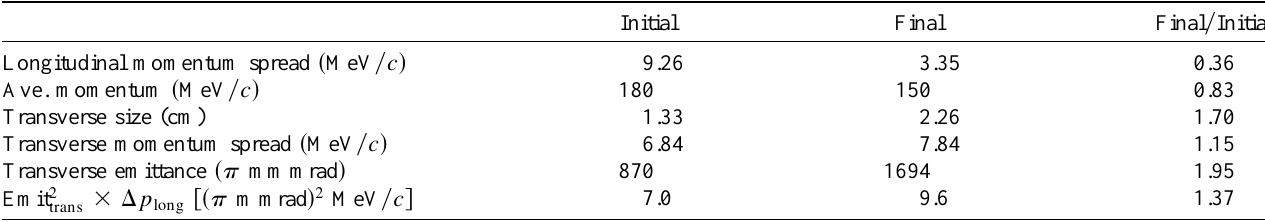
TABLE VII. Initial and final beam parameters in a longitudinal emittance exchange section. Initial Final Final (cid:1) Initial Longitudinal momentum spread (cid:3) MeV (cid:1) c (cid:4)